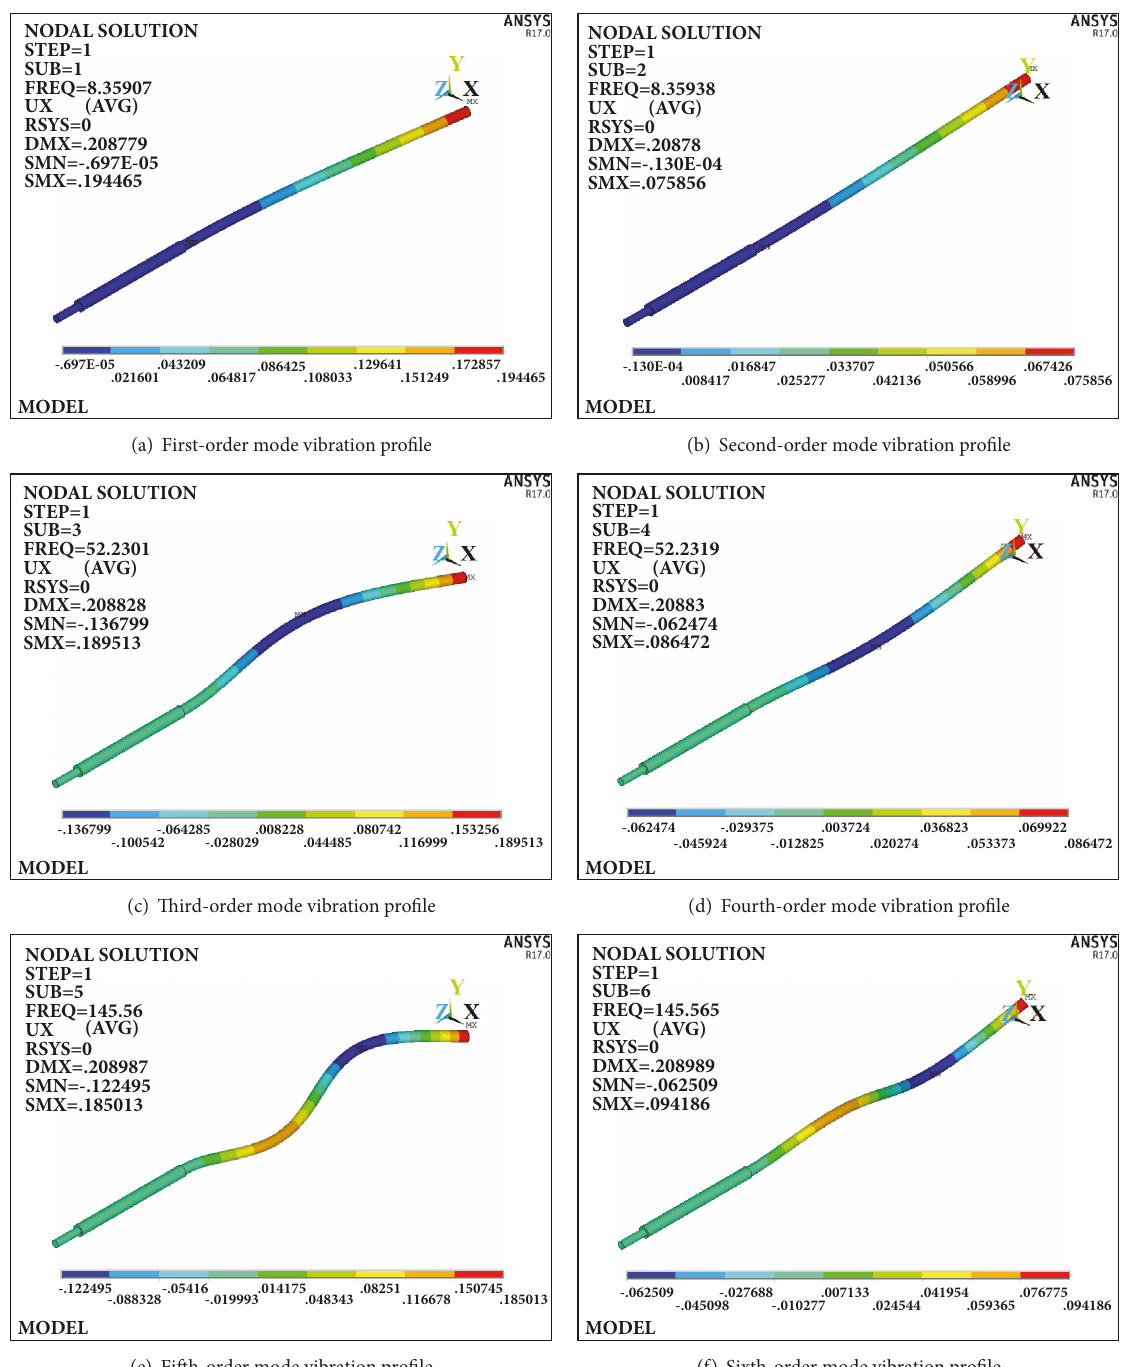
Figure 17: The first six-order mode vibration profile of main